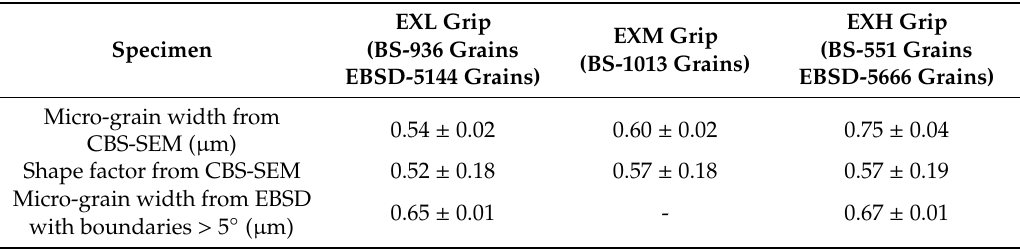
Table 5. Comparison of average micro-grain width measured from CBS-SEM and EBSD maps between EXL, EXM, and EXH materials (95% confidence indexes are